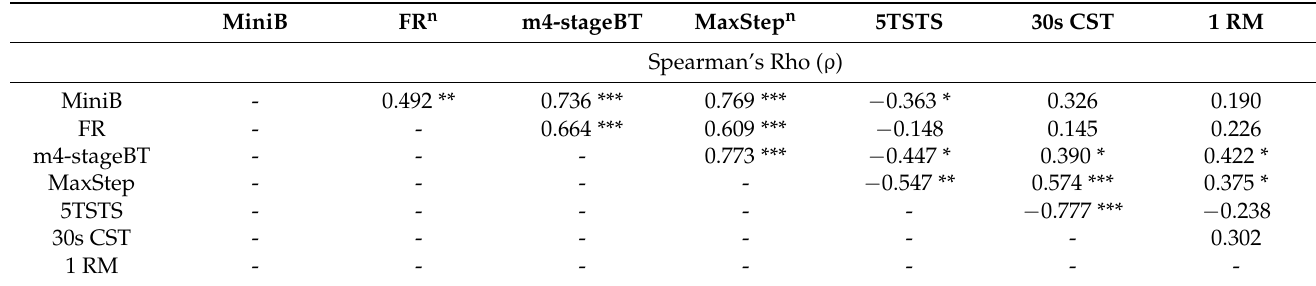
Table 3. The Spearman’s rho ( ρ ) correlation between the clinical instruments.